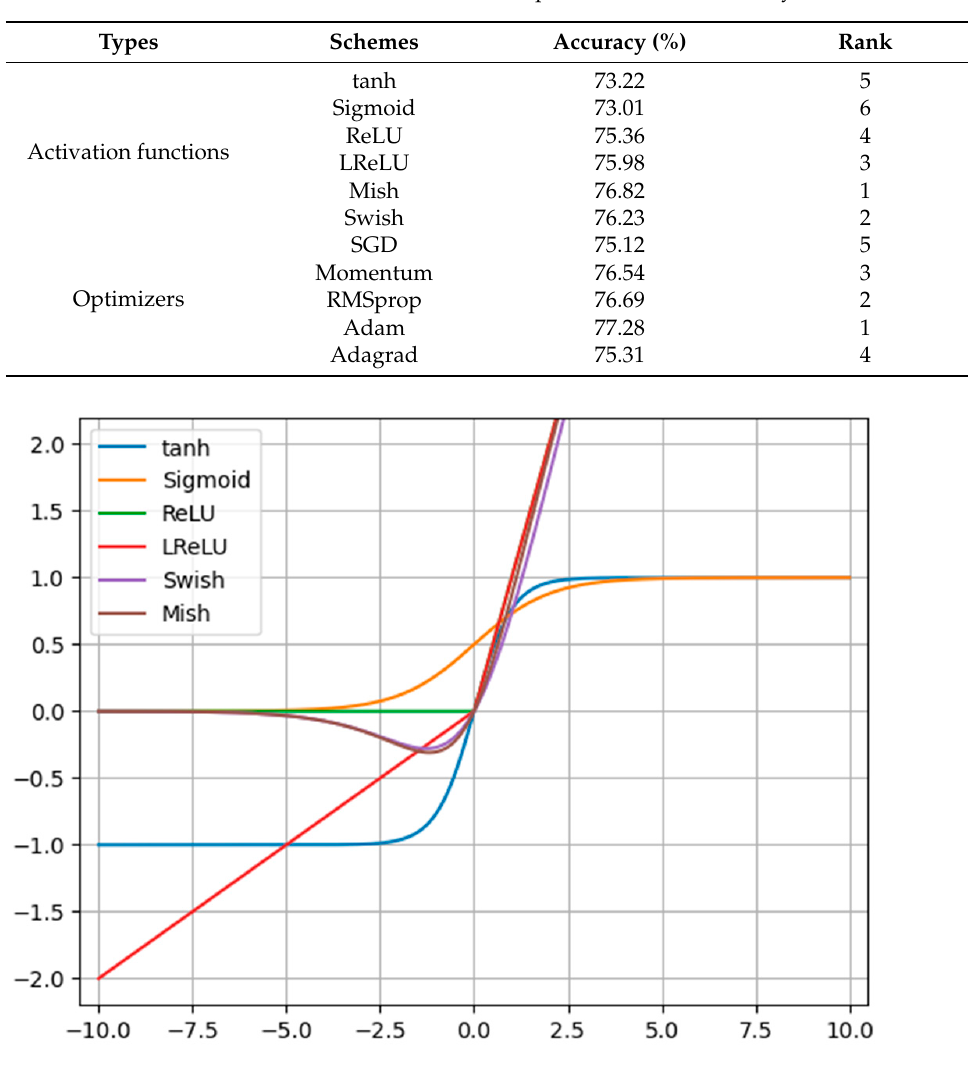
Table 9. Effects of different activation functions and optimizers on test accuracy.